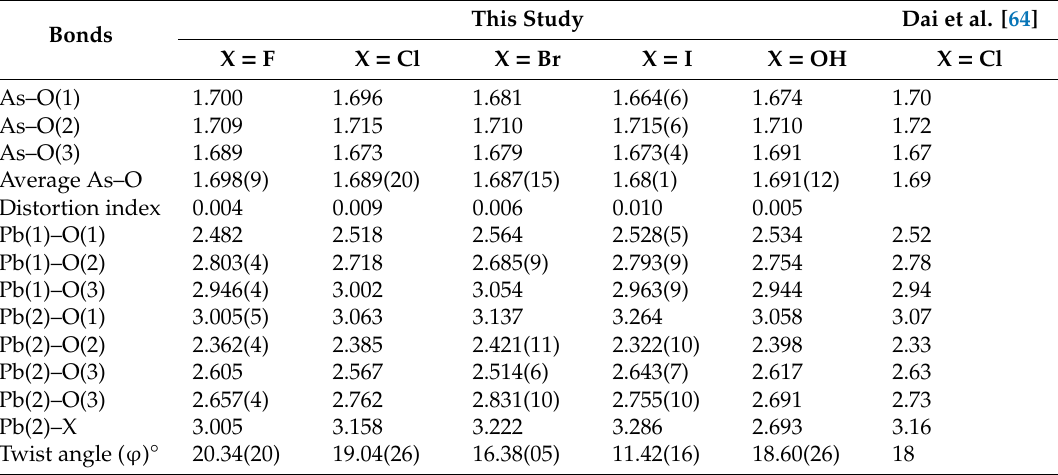
Table 3. Selected interatomic distances [Å] and twist angles ( ϕ ) ◦ for substituted mimetites Pb5(AsO4)3X. Previously published data for Pb5(AsO4)3Cl are included for